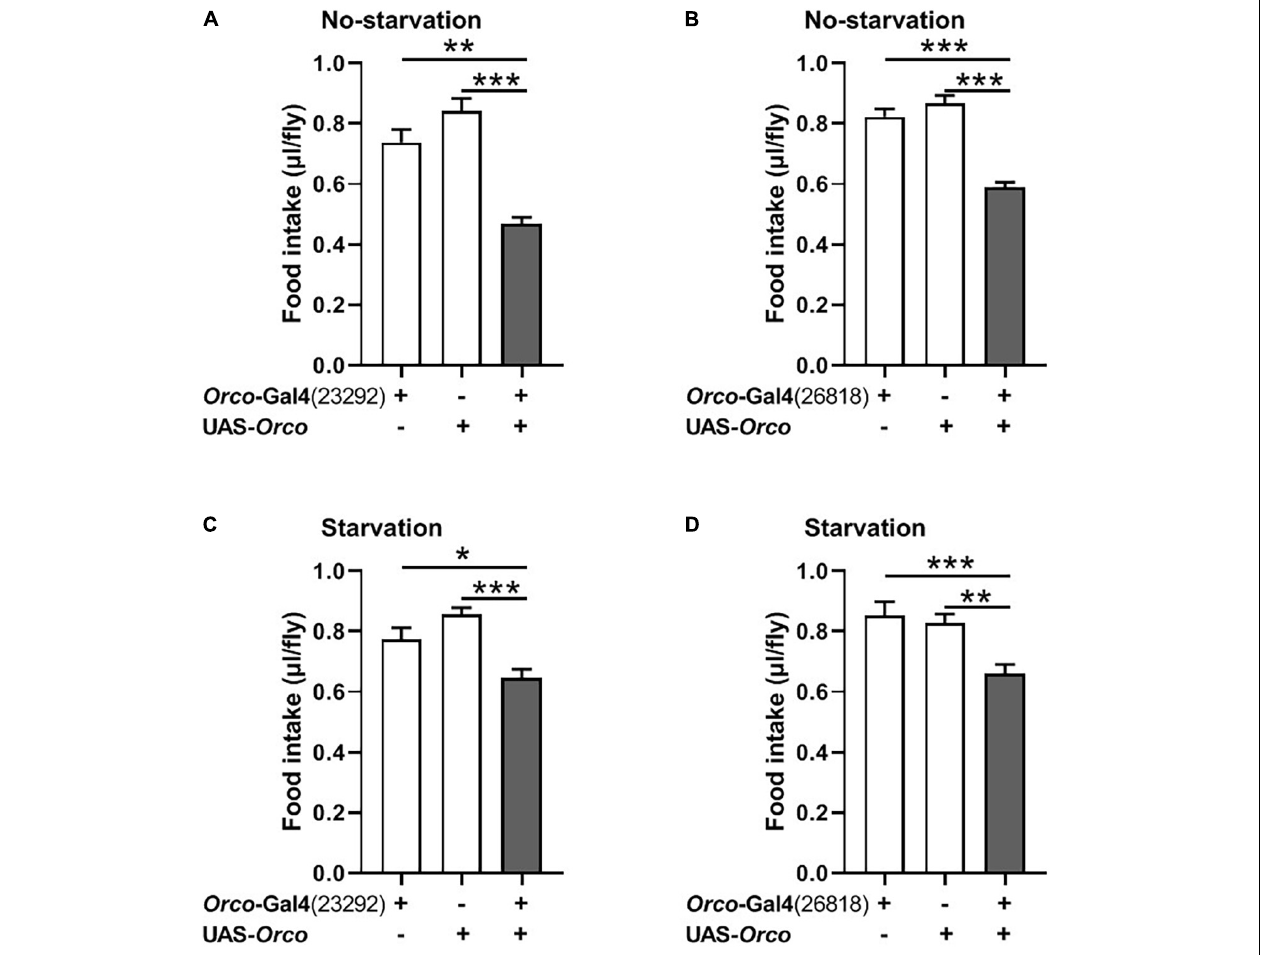
FIGURE 3 | Overexpressing orco in OSNs decreases food consumption. Flies expressing orco in both Orco-GAL4 drive (#23292 and #26818) eaten less food in the non-starved state (A,B) and starved state (C,D) , n = 15–21. One-way ANOVA followed by Dunnett’s post hoc test was used to analyze the difference. ** p < 0.01 and *** p <